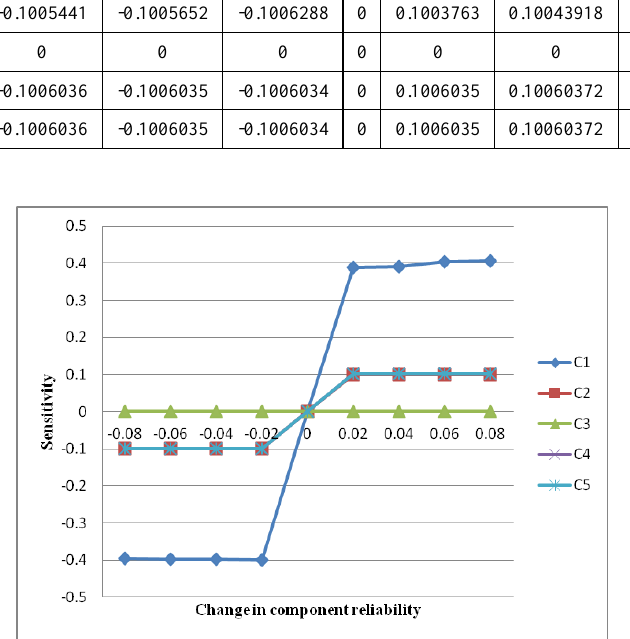
Figure 6. Sensitivity analysis (Scenario